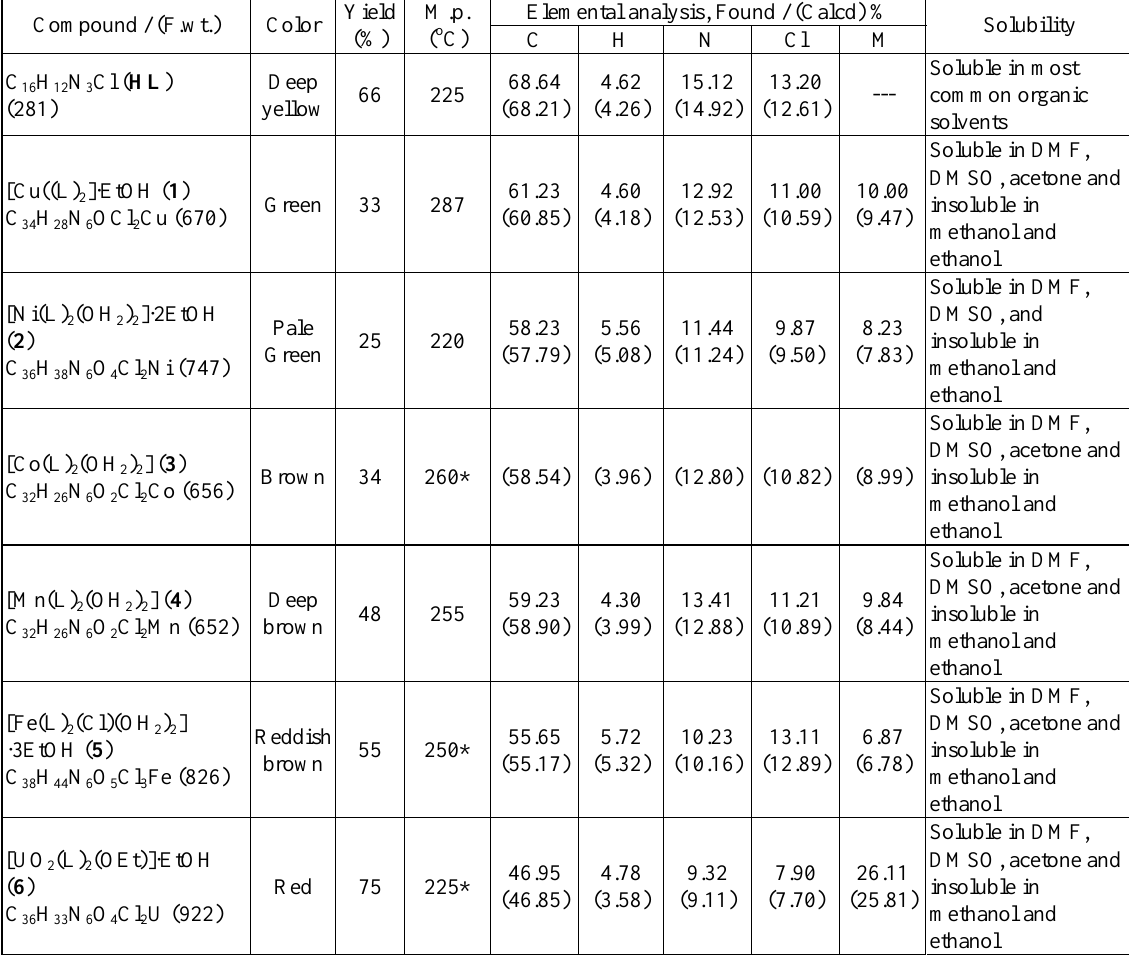
Table 1. Elemental analyses, color, yields and melting points of the ligand and its metal complexes. Elemental analysis, Found / (Calcd) % Compound / (F.wt.)